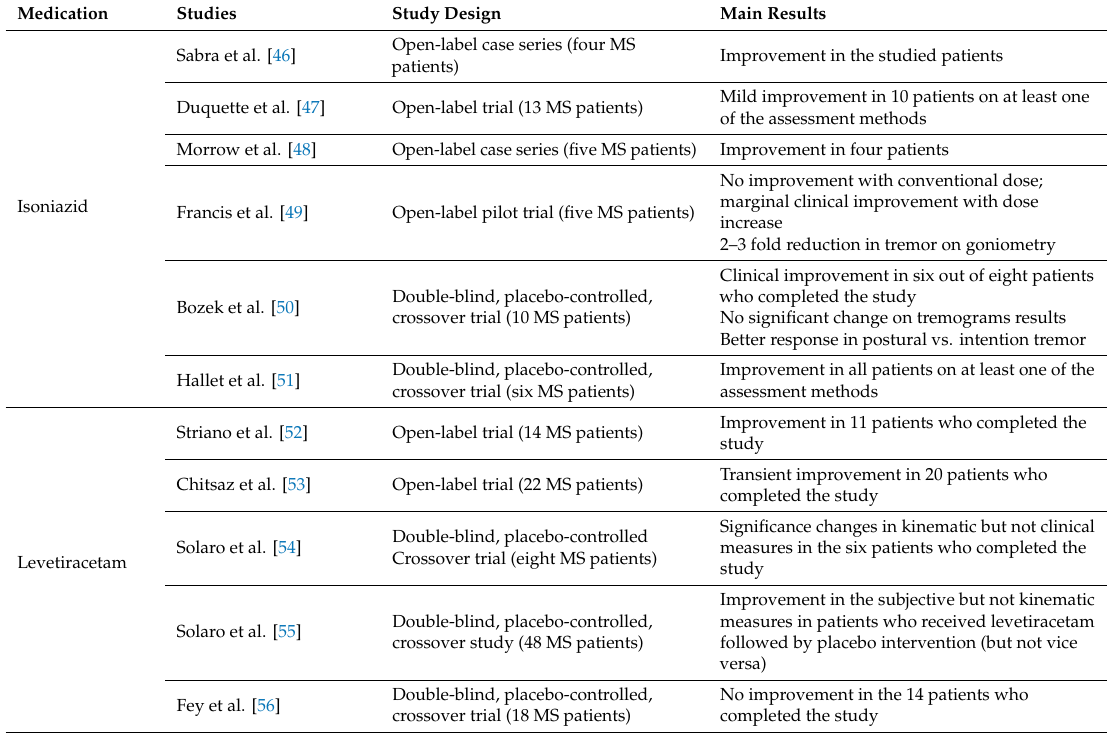
Table A1. Summary of pharmacological trials that targeted tremor in multiple sclerosis